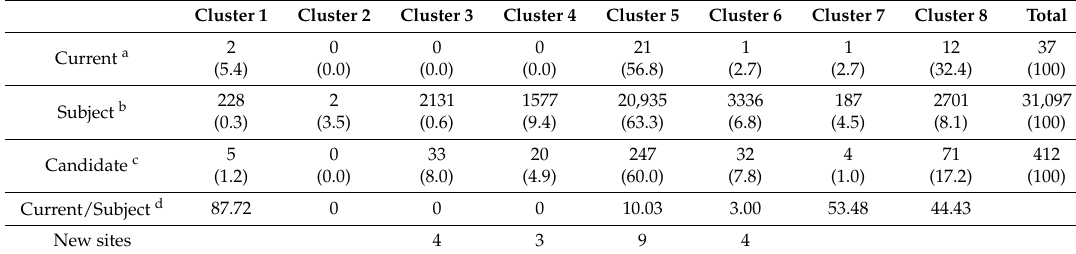
Table 3. Numbers (%) of subject, current, and candidate locations, proportions of current to subject locations, and numbers of new selected sites across nine clusters for NO 2